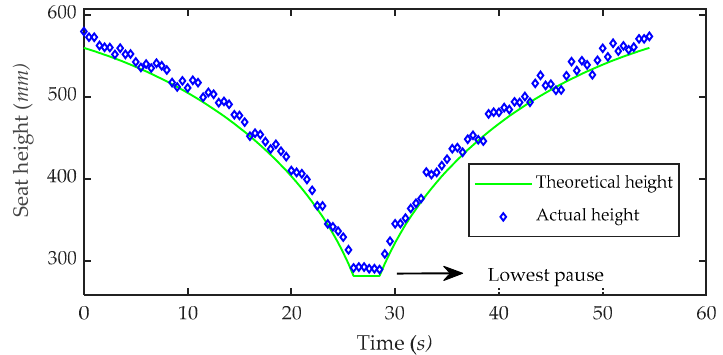
Figure 18. Experimental results of height adjustment.